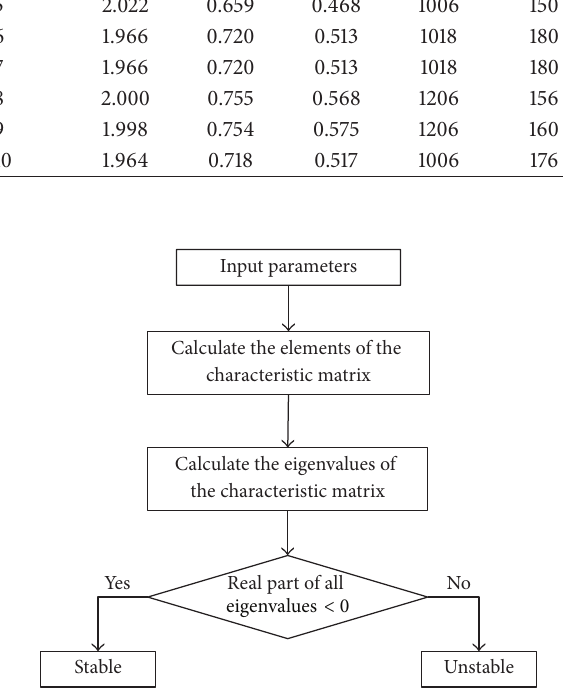
Figure 7: Calculation flow chart of critical rolling